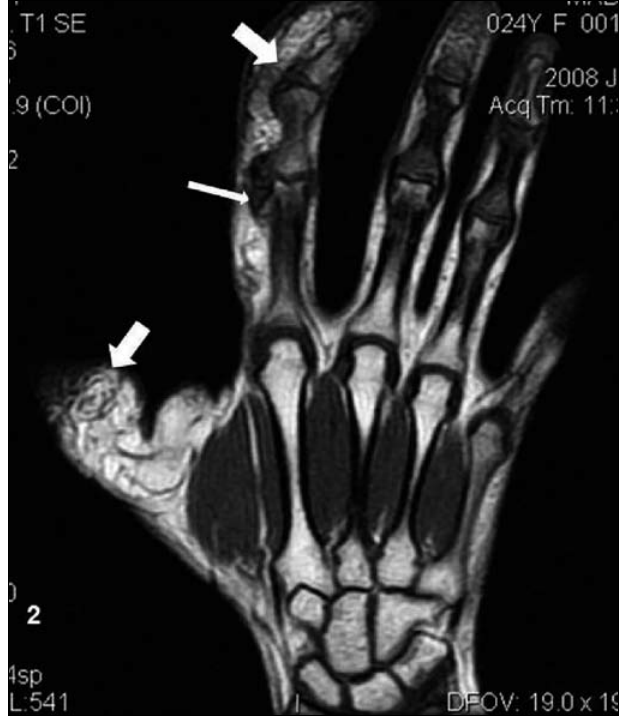
Fig. 2. T1W coronal image of the left hand showing focal hypertrophy of the thumb and index finger (distribution of median nerve) owing to enlarged soft tissue showing a striated pattern with fatty infiltration ( thick white arrow). Bony excrescences are seen in involved phalanges (thin white